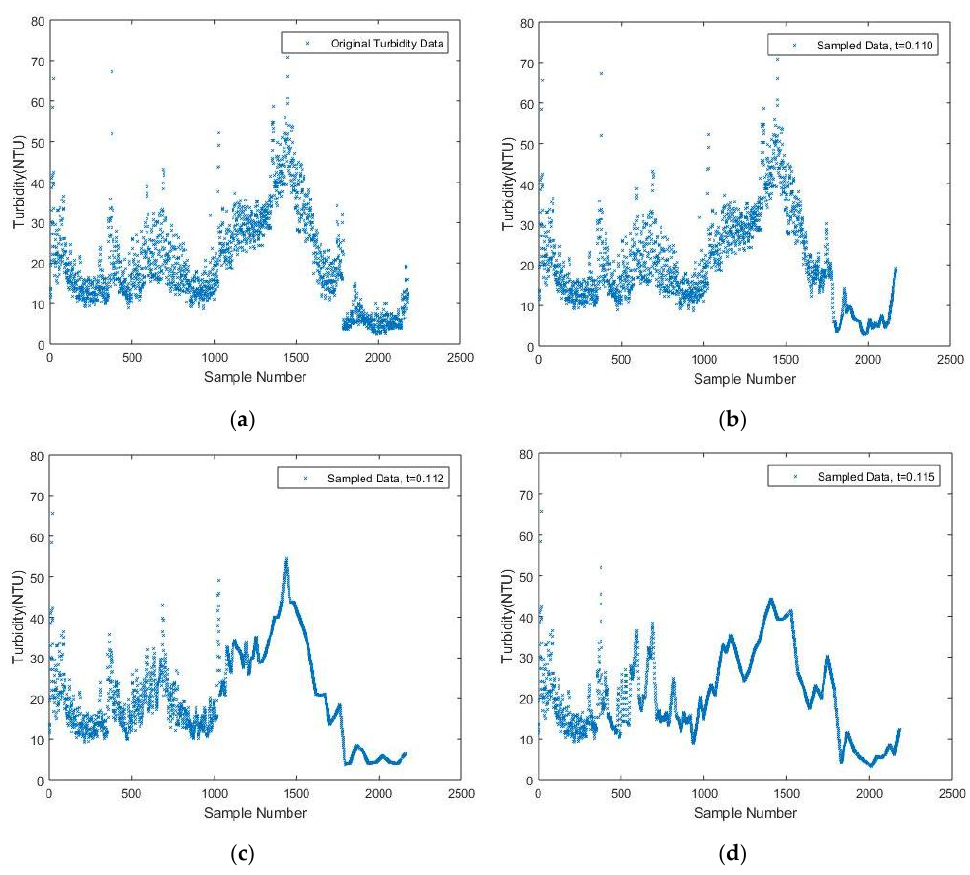
Figure 6. ( a ) Original Turbidity data; ( b ) Sampled Turbidity data with t = 0.110; ( c ) Sampled Turbidity data with t = 0.112; ( d ) Sampled Turbidity data with t = 0.115.